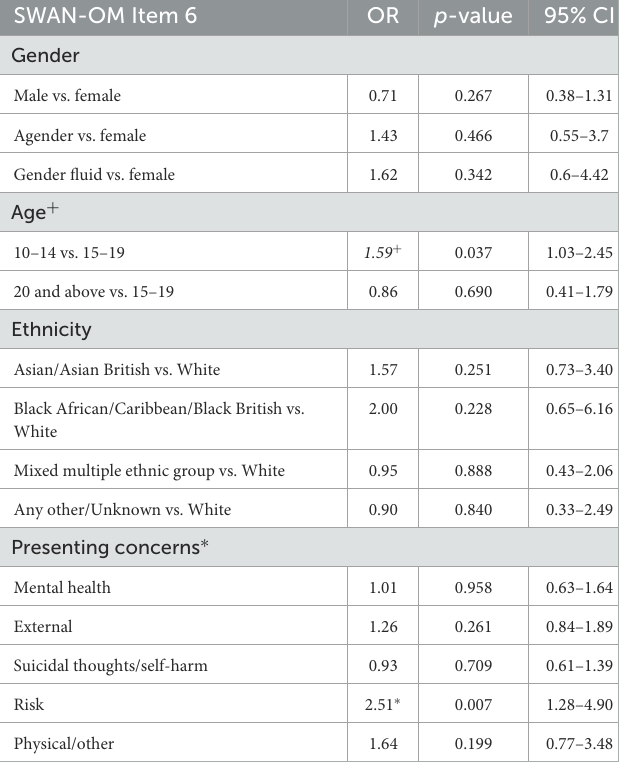
TABLE 5 Results of the hierarchical multi-level logistic regressions for SWAN-OM Item 6: “ Feel listened to ” a . SWAN-OM Item